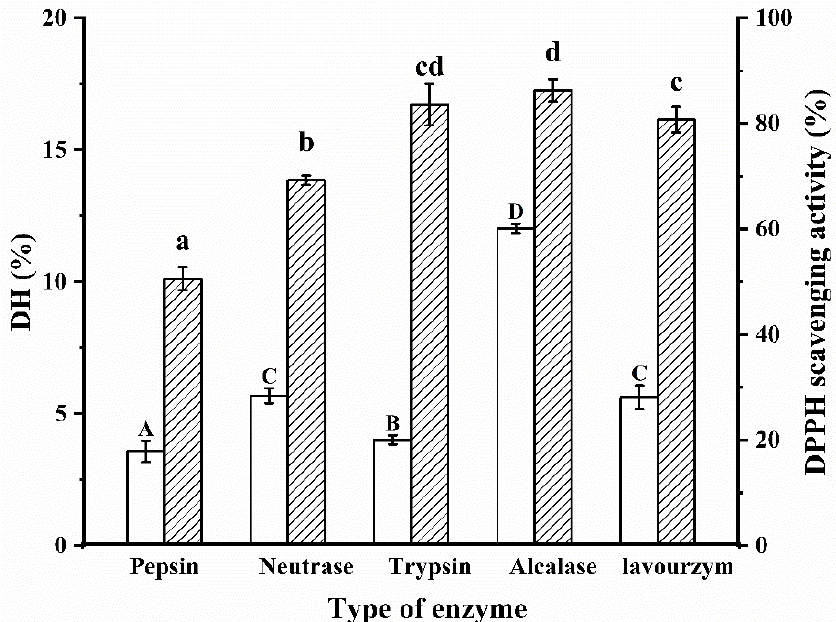
Figure 1. Protease screening. Different letters indicate significant differences in the same indica-tor. Capital letters represent the significant difference of DH of WPI under different proteases, and lowercase letters represent the significant difference of DPPH radical scavenging activity of WPI under different proteases.